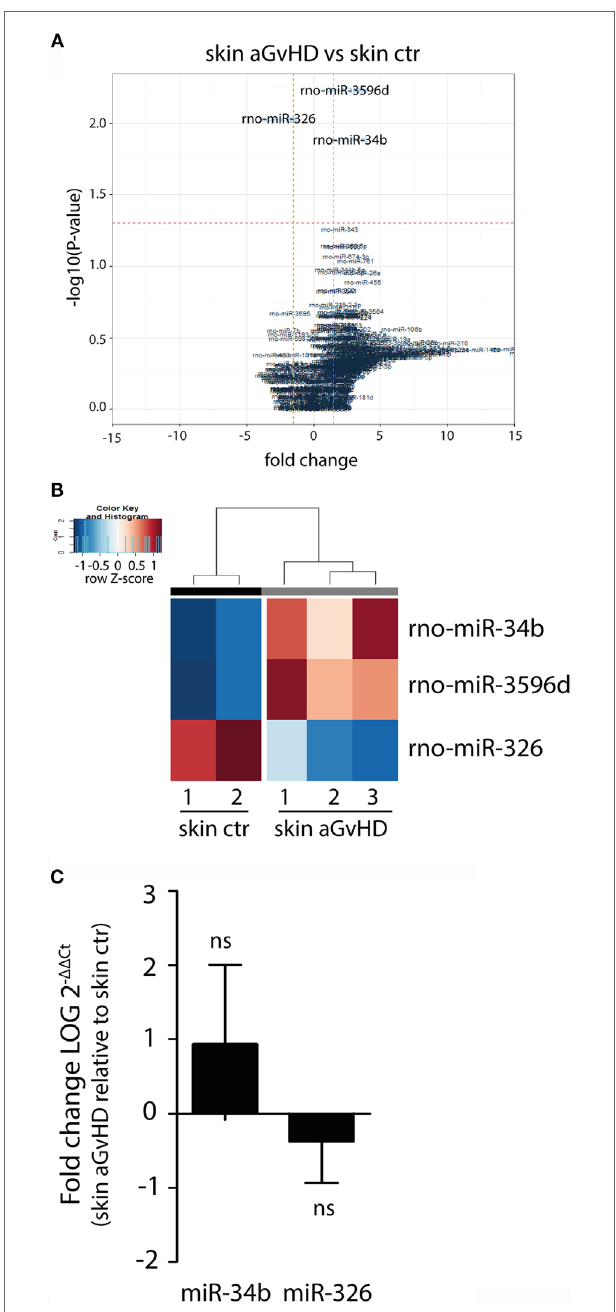
FigUre 1 | mirna expression signature in skin during agvhD . (a) Volcano plot showing the relationship between fold change and significance between the two groups. The horizontal dashed line indicates cutoff for significance p < 0.05 ( − log10 p -value > 1.3) and the vertical lines for fold change ≥ 1.5/ ≤− 1.5. (B) Heatmap showing unsupervised hierarchical clustering of differentially expressed miRNAs in skin between control ( n = 2) and aGvHD ( n = 3) animals. Each column represents an individual rat. Relative fold change is indicated by the color scale (red: high; blue: low). (c) qRT-PCR analysis of miR-34b and miR-326 expression in skin of control ( n = 6) or aGvHD ( n = 6) rats. Samples were normalized to endogenous controls and expression levels reported as log of 2 −ΔΔ Ct ± SD. Significance was calculated using the Student’s t -test (two-tailed) with Welch’s